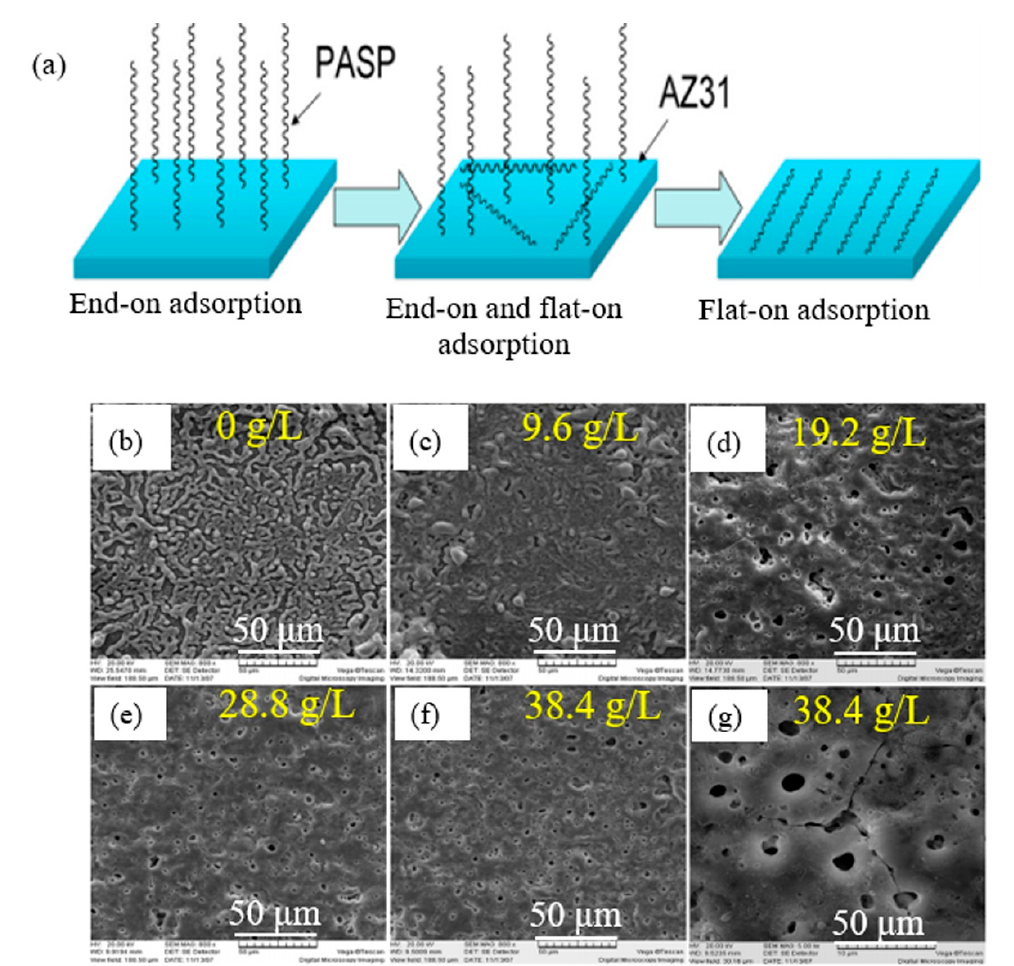
Figure 5. ( a ) The plausible adsorption configurations modes of polyaspartic acid (PASP) on the substrate surface during PEO. ( b – g ) The surface morphologies of the coatings obtained in electrolytes with different concentrations of PASP: ( b ) 0 g/L; ( c ) 9.6 g/L; ( d ) 19.2 g/L; ( e ) 28.8 g/L; ( f ) and ( g ) 38.4 g/L. Reprinted from permission from [32]. Copyright 2011 Elsevier.